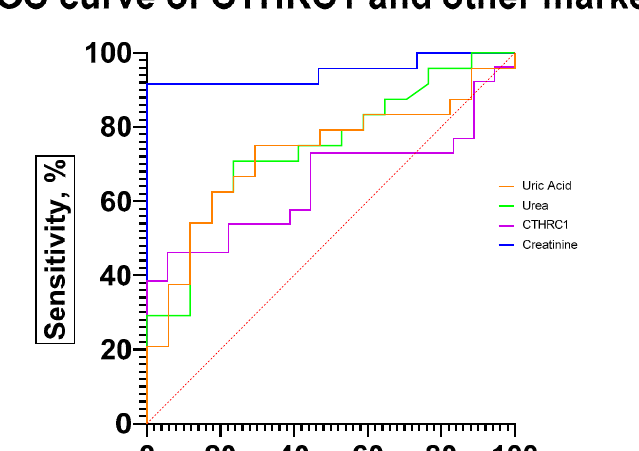
Figure 4. Correlation between plasma levels of CTHRC1, creatinine and blood cells. The relationship between variables was evaluated using Pearson’s correlation test. Trend lines indicate linear corre- lation. Pearson’s (r) coefficient and the corresponding p -values are shown on each plot. Scatter plot graphs illustrating correlation between CTHRC1 and WBCs ( A ), CTHRC1 and neutrophils ( B ), CTHRC1 and basophils ( D ), CTHRC1 and eosinophils ( E ) and CTHRC1 and ESR ( C ) in the CKD group. In addition, similar correlation analysis between creatinine and WBCs ( F ), creatinine and neutrophils ( G ), creatinine and ESR ( H ), creatinine and basophils ( I ), and creatinine and eosinophils ( J ) is displayed. WBC—white blood cells; NEUT—neutrophils.